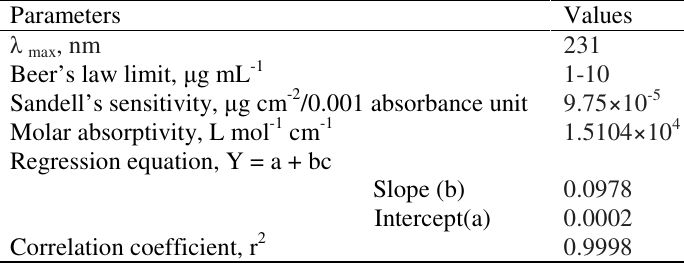
Table 1 . Optical characteristics of proposed method.